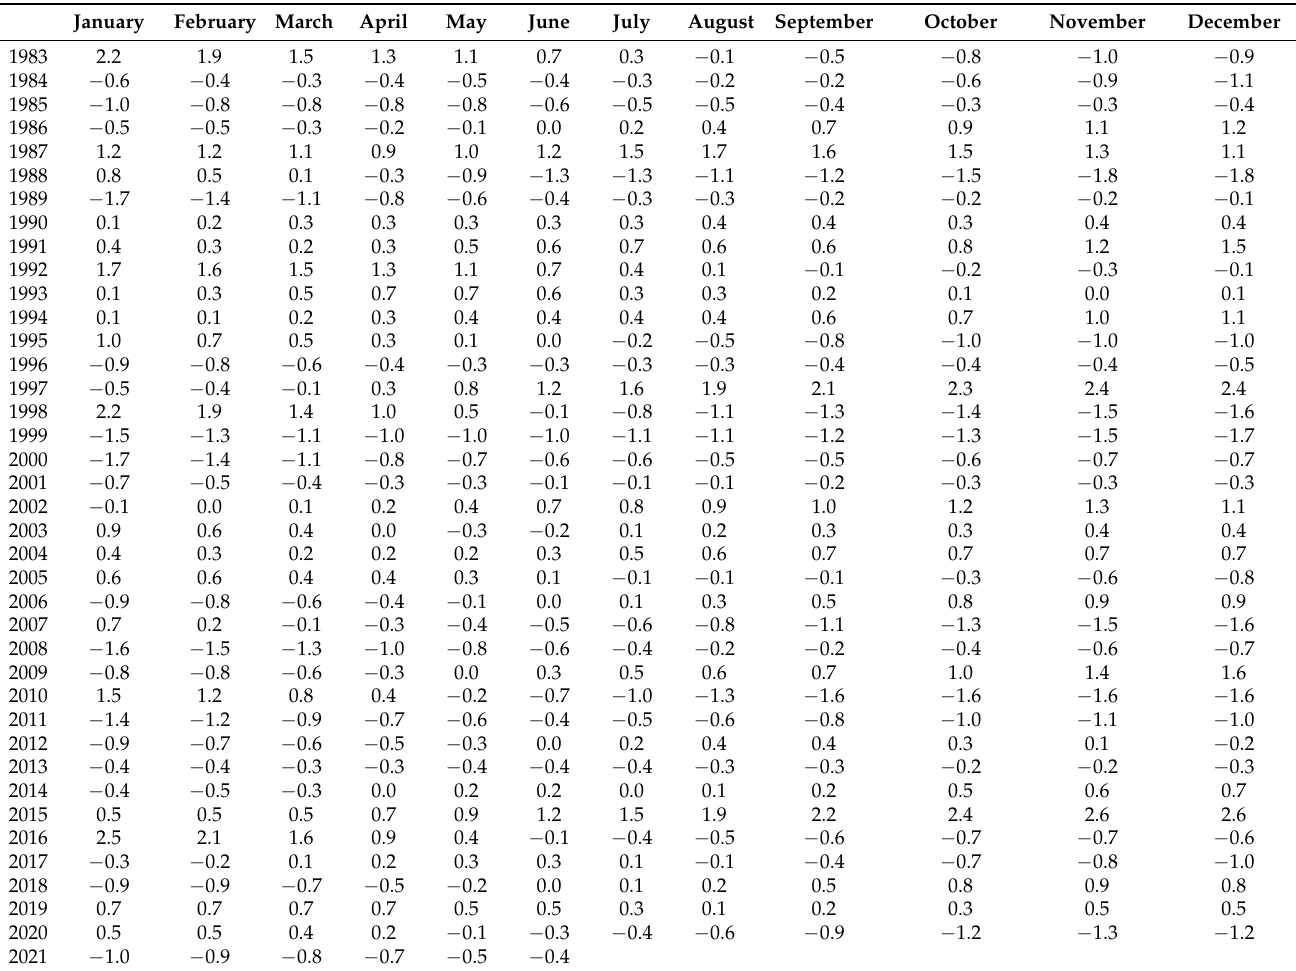
Table A4. Oceanic Niño Index (ONI) from January 1983 to June 2021